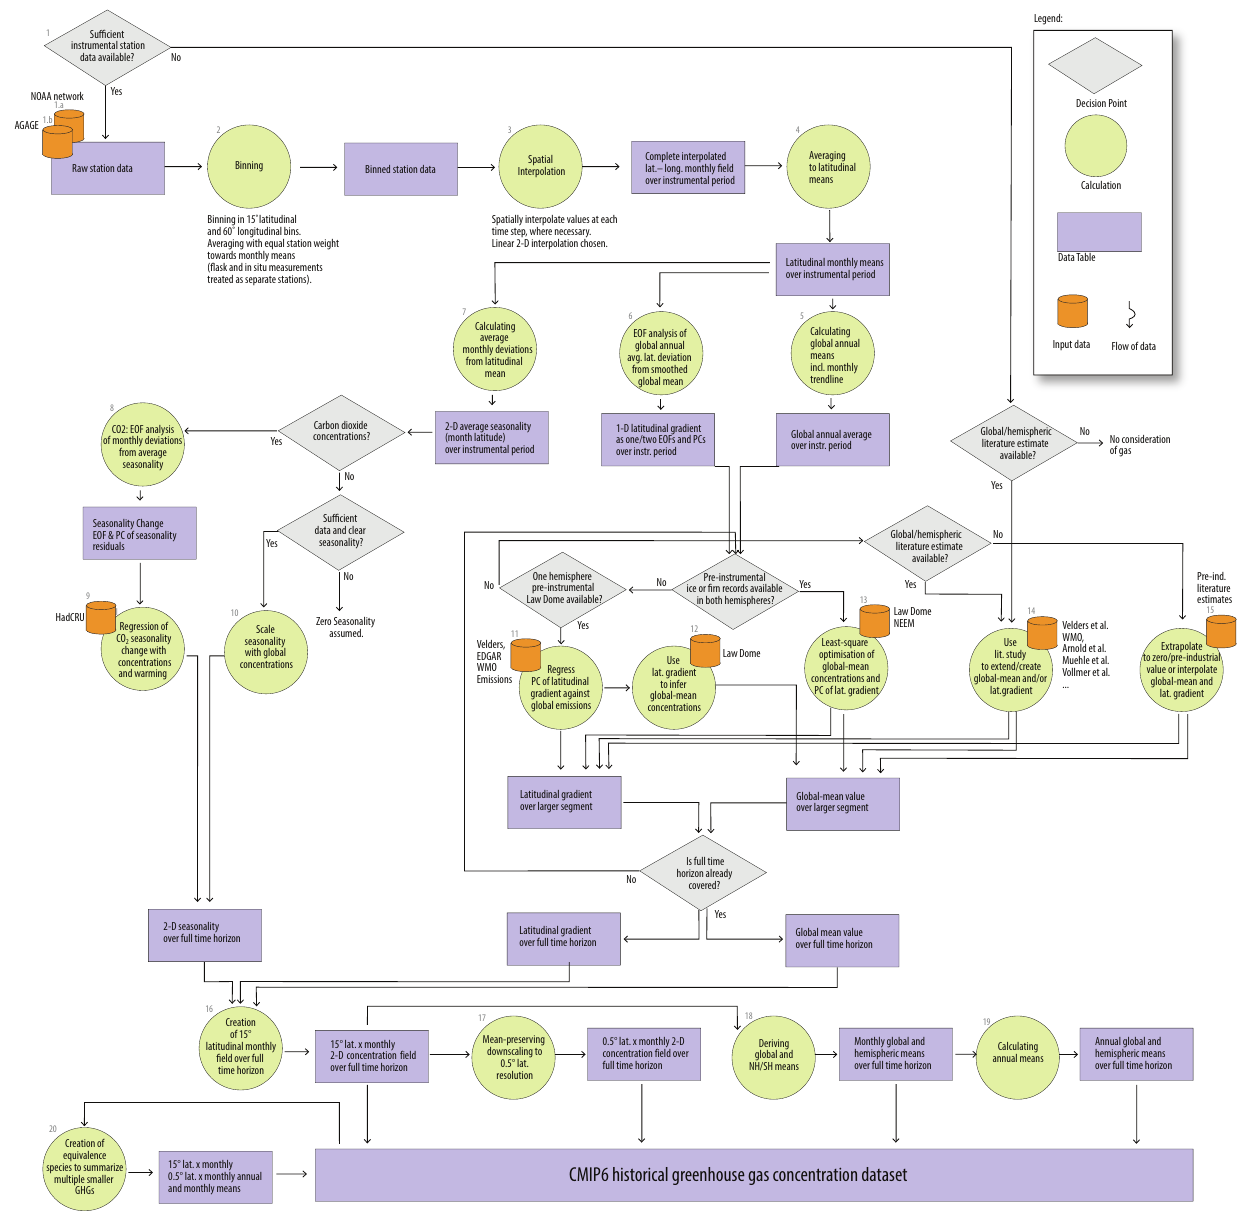
Figure 1. Data-flow diagram of how historical GHG concentrations are derived in this study. See text.